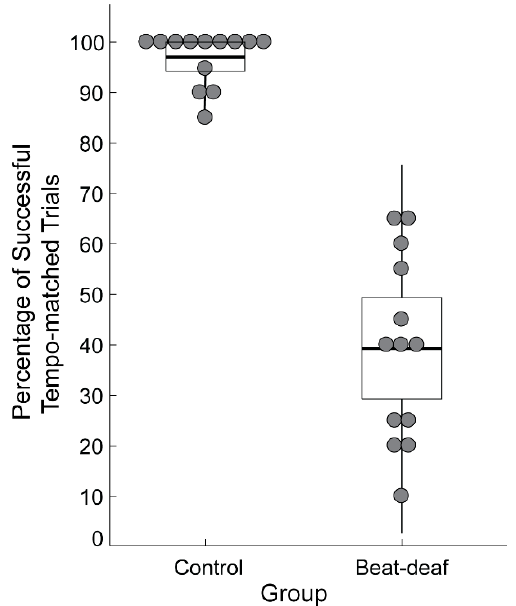
Figure 1. Performance of participants in the control and beat-deaf groups in the beat production task of the Montreal Beat Alignment Test (M-BAT). Each dot represents a participant. Boxes correspond to a 95% confidence interval from the mean based on the standard error of the mean (SEM). The black horizontal line within each box indicates the group mean. The vertical lines represent two standard deviations from the